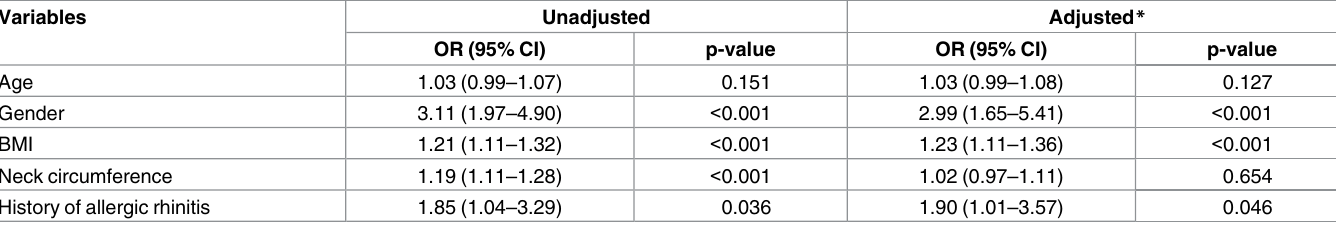
Table 3. Univariate and multivariate analysis of affecting factors for sleep disordered breathing.